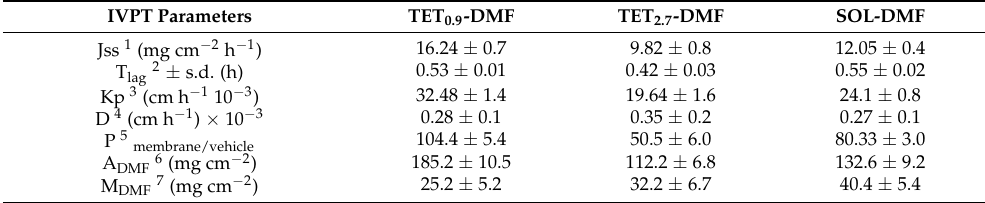
Table 4. IVPT parameters of the indicated forms, as determined by Franz cells associated with Strat-M ® .